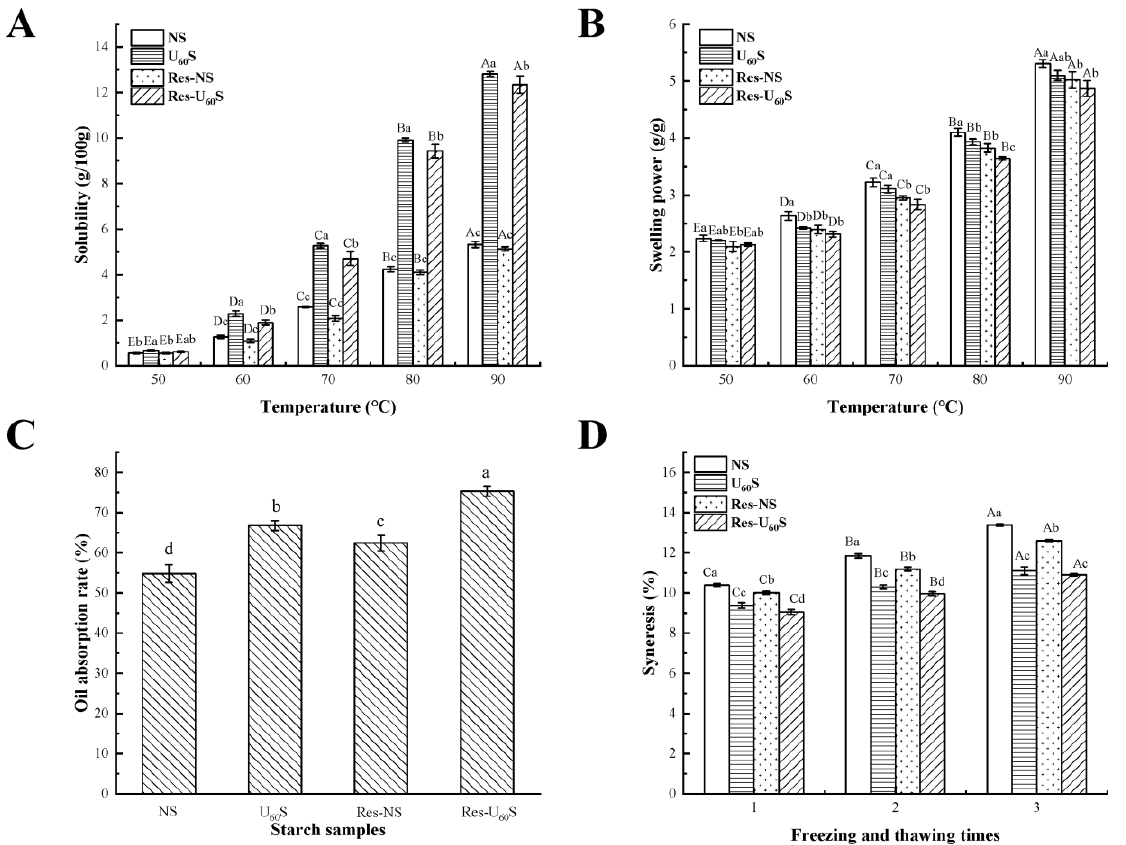
Figure 2. Solubility and swelling power of banana starch affected by ultrasonication and resveratrol ( A , B ). ( C ) Oil-absorption capacity of different starch samples. ( D ) The changes in syneresis of different banana starches. Lowercase letters indicate a statistically significant difference within the group ( p ≤ 0.05), and uppercase letters indicate a statistically significant difference between groups ( p ≤ 0.05). Error bars represent standard deviation (n = 3).